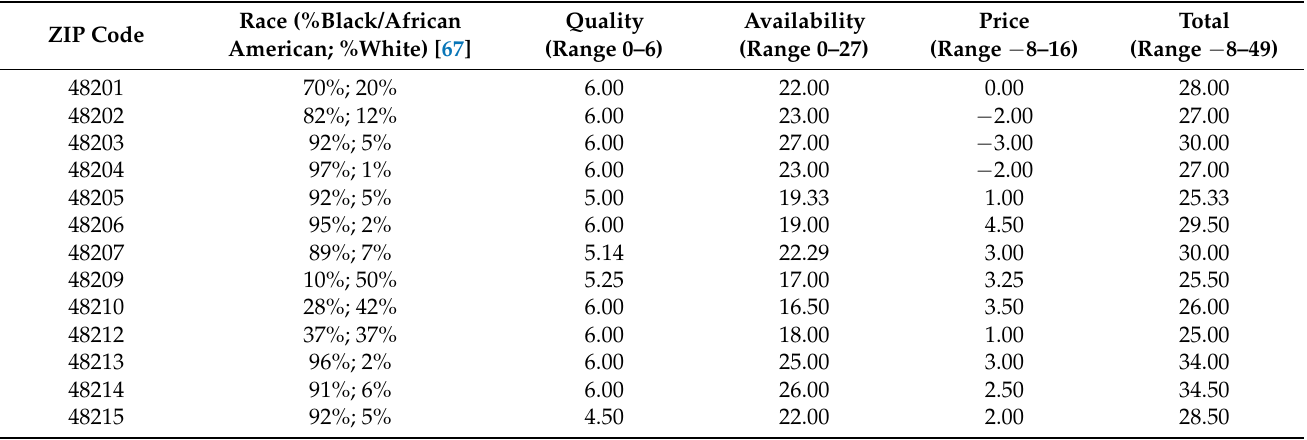
Table 1. Results of the NEMS scoring: Means by ZIP